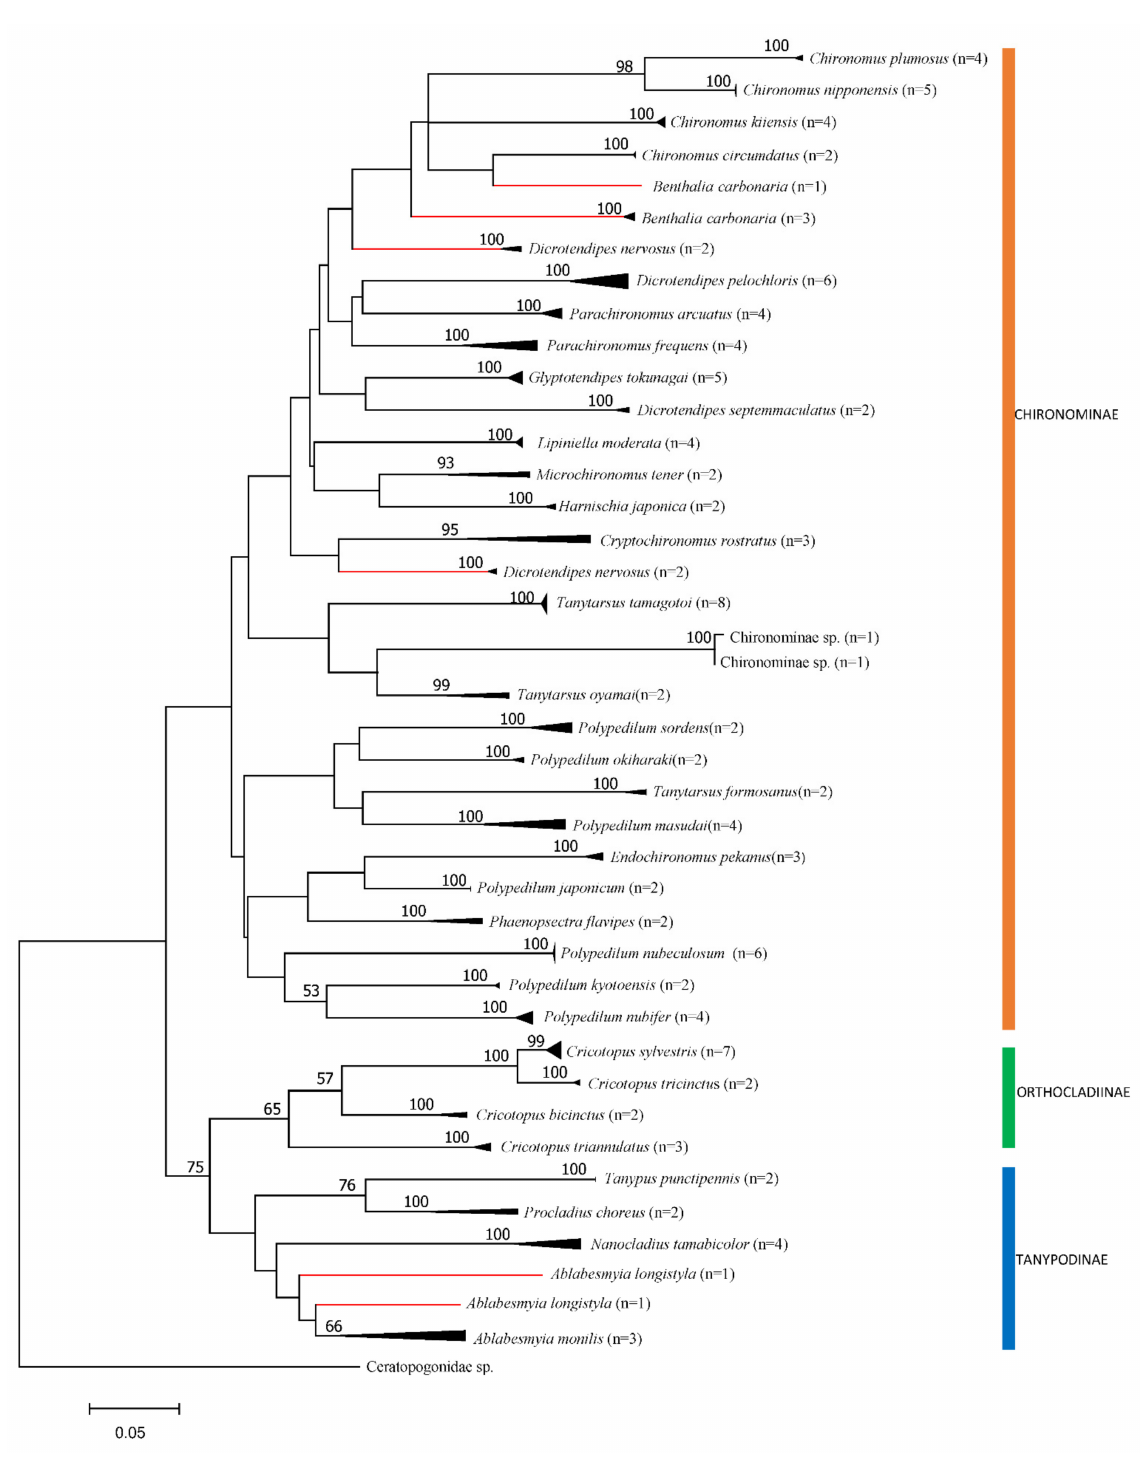
Figure 3. Maximum likelihood tree of COI sequences from chironomids collected from large rivers in South Korea. Node values indicate bootstrap values (1000 replicates) of >50%. Scale bar corresponds to 0.05 changes per